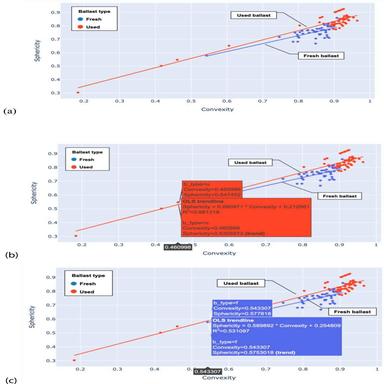
Result of the OLS model: (a) fresh and used ballast trend line; (b) statistic trendline of used ballast; and (c) fresh ballast.